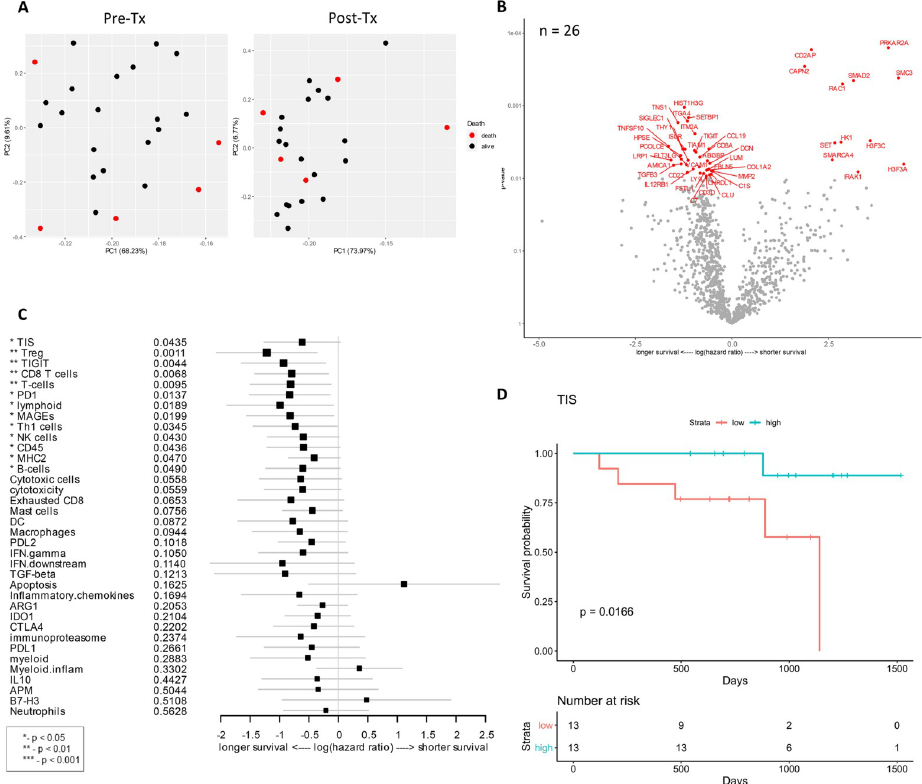
Fig 3. Genes and signatures associated with overall survival of patients treated with combination immunotherapy of HDI and ipilimumab as a neoadjuvant therapy. A ) Principal component analysis was performed to look for distinct gene expression patterns in baseline vs. post-treatment samples by OS. B ) Volcano plot of unadjusted p -value vs. log-hazard ratio of the differential expression associated with overall survival of treated patients (unadjusted p < 0.01). Among 27 evaluable patients, 26 samples were available for this analysis. C ) Forest plot of difference of gene signature scores based on hazard ratio between longer survival and shorter survival. The position of the squared dots denotes the difference of score, and the size denotes the statistical significance. The horizontal lines are the Wald-type confidence intervals. The � sign denotes the significance of p -value ( < 0.01 �� , < 0.05 � ). D ) The Kaplan-Meier curves of TIS score groups for available samples (n = 26). Patients are stratified into “high” and “low” groups based on the TIS score 50% quantile. The Kaplan-Meier curves show that the high TIS score group has higher survival rate than the low TIS score group. The survival time was fit to TIS score group (high vs. low) with Cox proportional hazard model ( p - value =